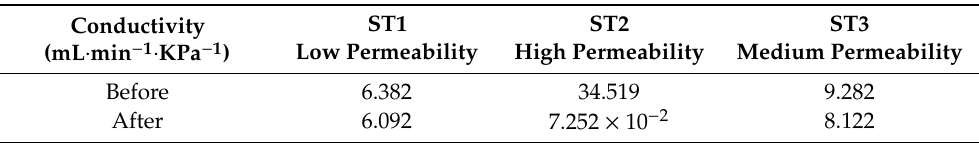
Figure 9. The conductivity of the porous medium before and after gel injection as a function of the pore volumes injected (PVI) of oil in each Slim Tube separately. Base curves correspond to the conductivity before the first waterflooding and post gel curves to the reduced conductivity after the gel plugging. The porous medium is composed of Ottawa sand mesh sizes 8–20 (17%), 40–70 (50%), and 100–200 (33%) for the low permeability slim tube (ST1), 20–40 (100%) for the high permeability sand pack (ST2), and 8–20 (10%), 40–70 (60%) and 100–200 (30%) for the medium permeability slim tube (ST3. The injection rate was kept constant at 5 mL · min − 1 . The test was performed at 60 ◦ C and 13.8 MPa of overburden pressure. Table 4. Average conductivity of the porous medium before and after gel injection in the triple parallel Slim Tube